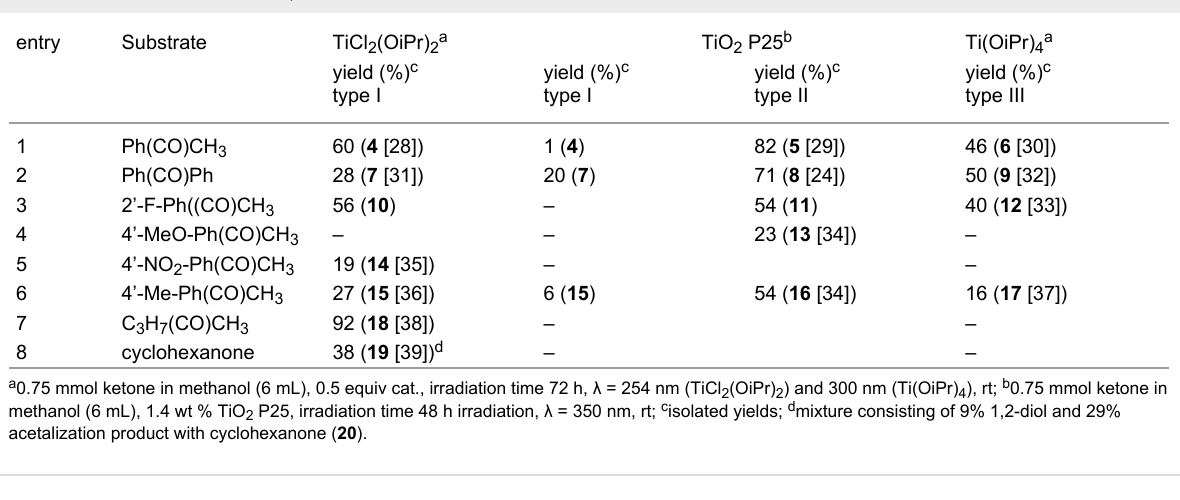
Table 2: Substrate variation under optimized conditions.